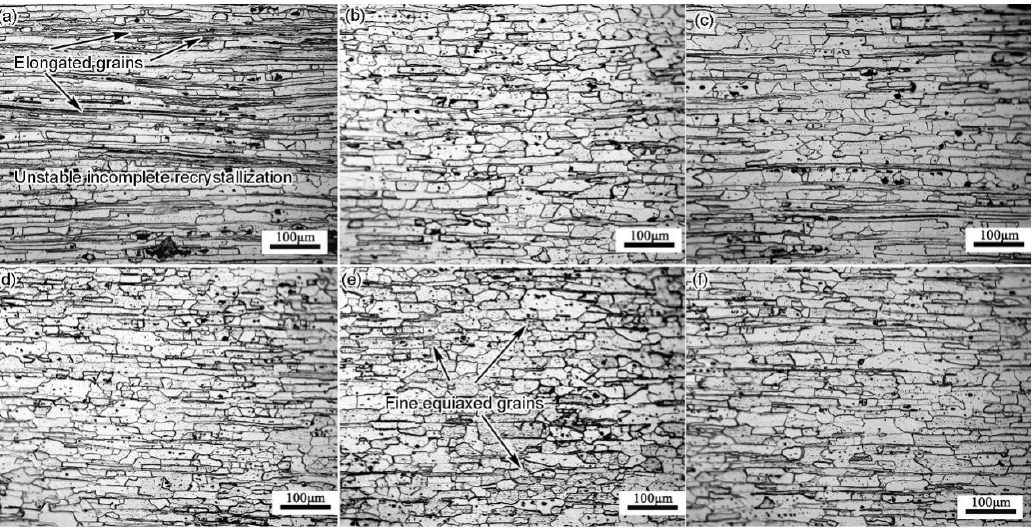
Figure 3. OM of the recrystallized sheets: ( a ) CRTMT; ( b ) DRTMT 1 ; ( c ) DRTMT 2 ; ( d ) DRTMT 3 ; ( e )DRTMT 4 ; ( f ) DRTMT 5 .